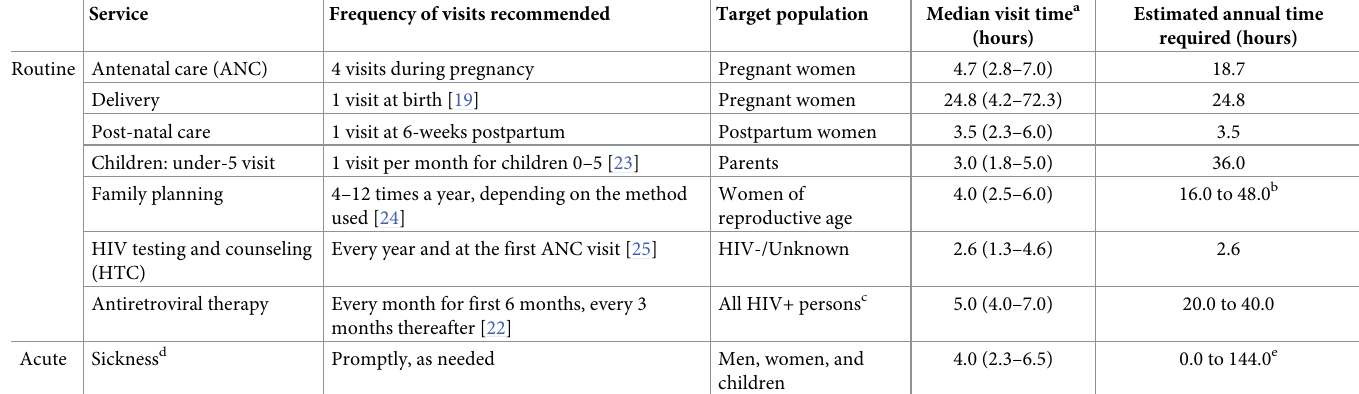
Table 1. Malawi government recommended health care guidelines and estimated annual time required to meet